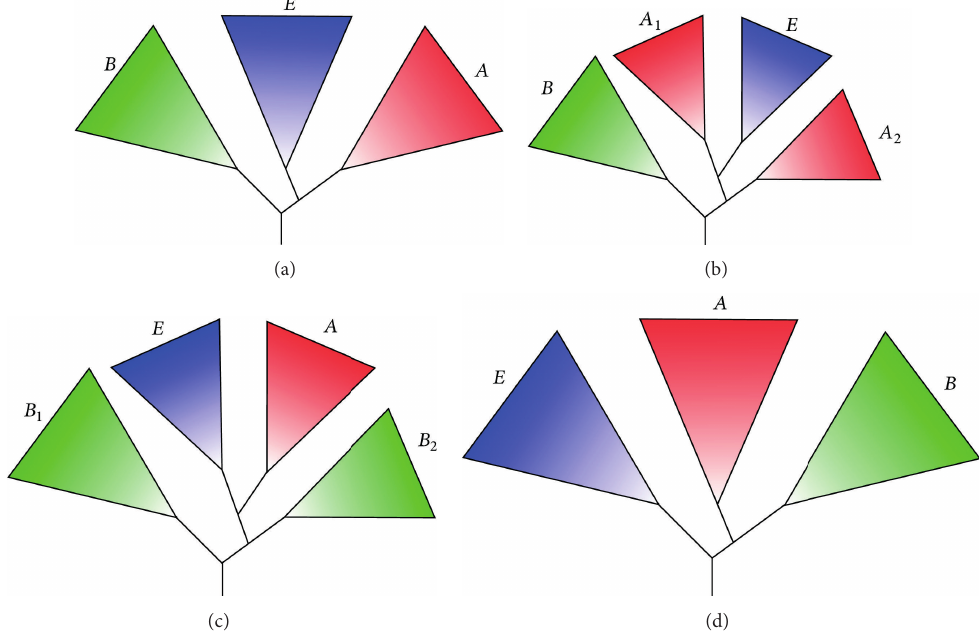
Figure 2: Overview of theories regarding the origin of the eukaryotic nuclear lineage. (a) The classical, Woesean three domains of life tree in which the nuclear lineage vertically evolved from the archaea-eukaryote common ancestor. (b) The fusion tree in which the nuclear lineage originated from the archaeal partner in the fusion. Depending on which fusion model, the archaeal parent’s lineage ( 𝐴 1 ) was either part of the euryarchaeota [SET [93], original syntrophy hypothesis [94], hydrogen hypothesis [95] or alternative syntrophy hypothesis [51]], the Crenarchaeota (eocyte hypothesis) [96], or the TACK superphylum (PhAT) [58]. “ 𝐴 2 ” represents all archaea not directly affiliated with “ 𝐴 1 .” (c) The neomuran tree in which the eukaryotic and archaeal lineage (combined referred to as “neomurans”), evolved vertically from ancestor shared with actinobacteria ( 𝐵 2 ) as a result of the loss of bacterial-type cell wall (the neomuran revolution). 𝐵 1 represents all bacteria not directly affiliated with 𝐵 2 . (d) The eukaryote-early tree, which suggests that the last common universal ancestor was more eukaryote-like than